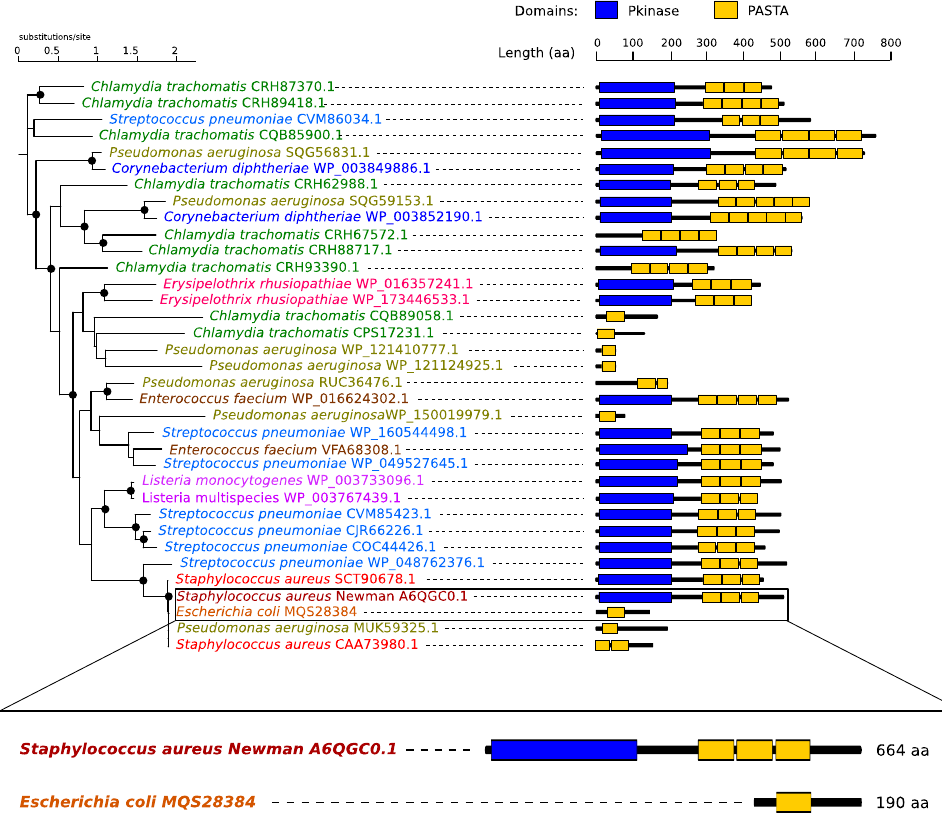
Figure 2. Phylogenetic tree of PASTA domains associated with the relevant bacteria. Predicted protein domains are shown on the right: kinase domains in blue and PASTA domains in yellow. Black circles indicate strongly supported branches (SH-like branch support values >0.8). Note in the box a schematic of the alignment between the PASTA domain-containing proteins in the species used in this study; Staphylococcus aureus Newman has a kinase containing a PASTA domain, whilst Escherichia coli lacks the kinase domain.